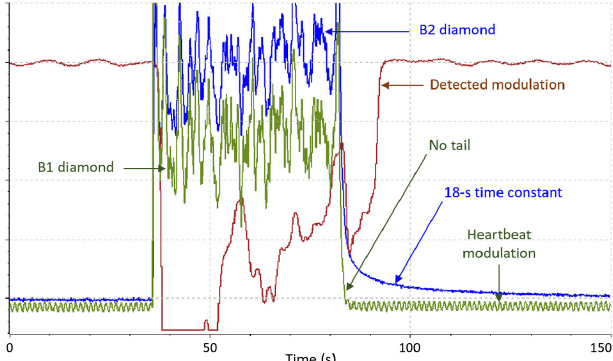
FIG. 15. Cividec single-crystal B1 (green line) and a poly- crystalline B2 (blue line) detectors measure a 1-W loss on an LCLS collimator as the beam rate was toggled between 0 and 120 Hz. The B2 exhibits a long decay tail. The red signal is the heartbeat amplitude detected by the DSP.